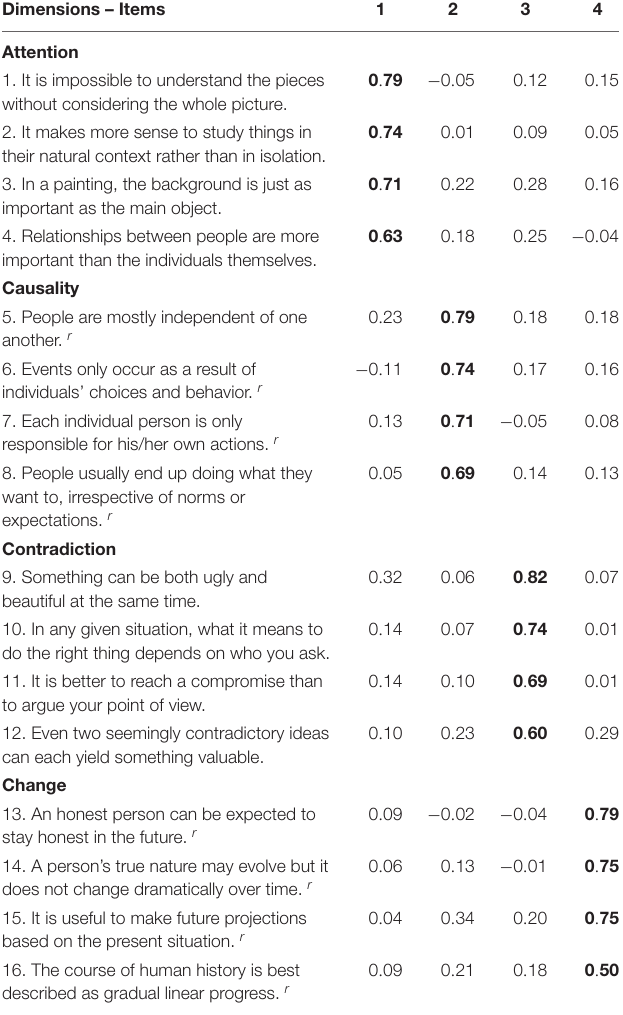
TABLE 6 | Study 3 – exploratory factor analysis of the 16-item HCS. Dimensions – Items